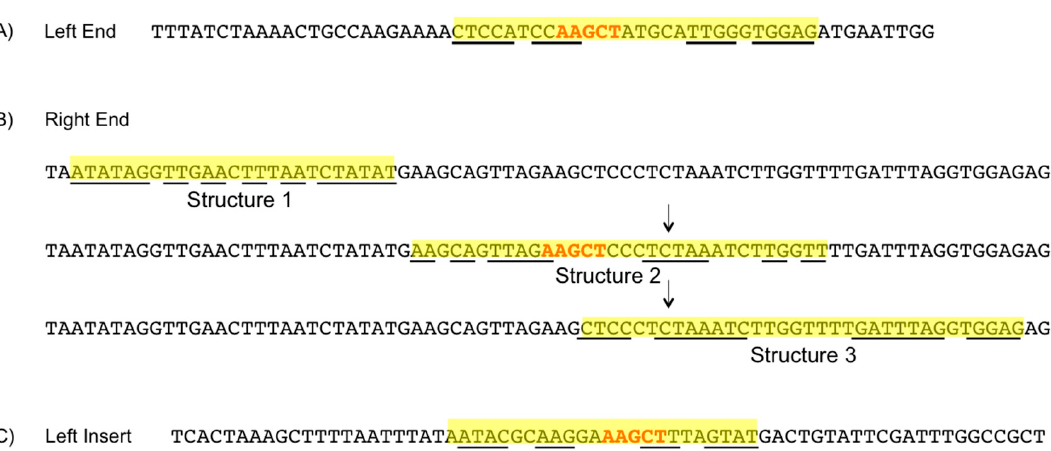
Figure 3. Sequences of IS605 potential hairpin structures from the tnpB strand organized from 5’ to 3’. Potential hairpin structures are highlighted in yellow. Complementary nucleotides forming the hairpin are underlined. Conserved AAGCT sequences between the hairpin loops are bolded in red text. ( A ) Left end. ( B ) Right end, where 50 nt from the 5’ end and 6 nt from the 3’ end are not shown. The arrows above structures two and three indicate where a 28-nt insert appears in elements with a type 2 RE disrupting these structures. ( C ) Left insert representative of the other LI, RI, and